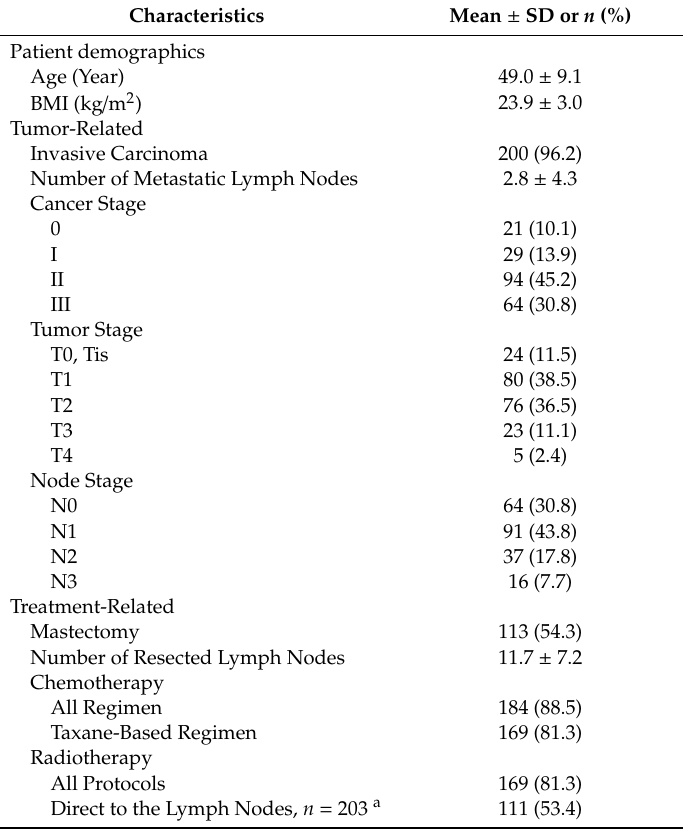
Table 1. Baseline characteristics of the study population ( n =